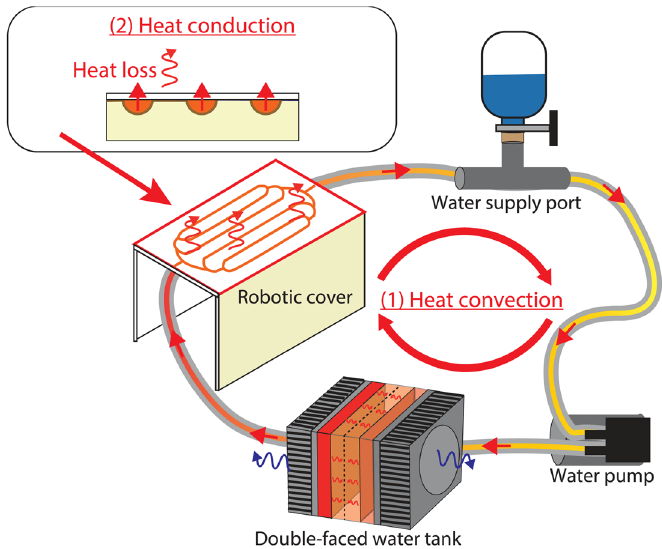
Figure 4. The circulating water system consists of the robotic cover, water supply port, Peltier devices embedded in the water tank and the micro water pump. There are three types of thermal effects in the system: absorbing/generating heat from Peltier devices based on a Peltier effect, heat convection through the circulating water (1), and heat conduction through the surface layer (gel) of the robotic cover (2). The water temperature is controlled by Peltier devices so that the robotic cover’s temperature matches the desired